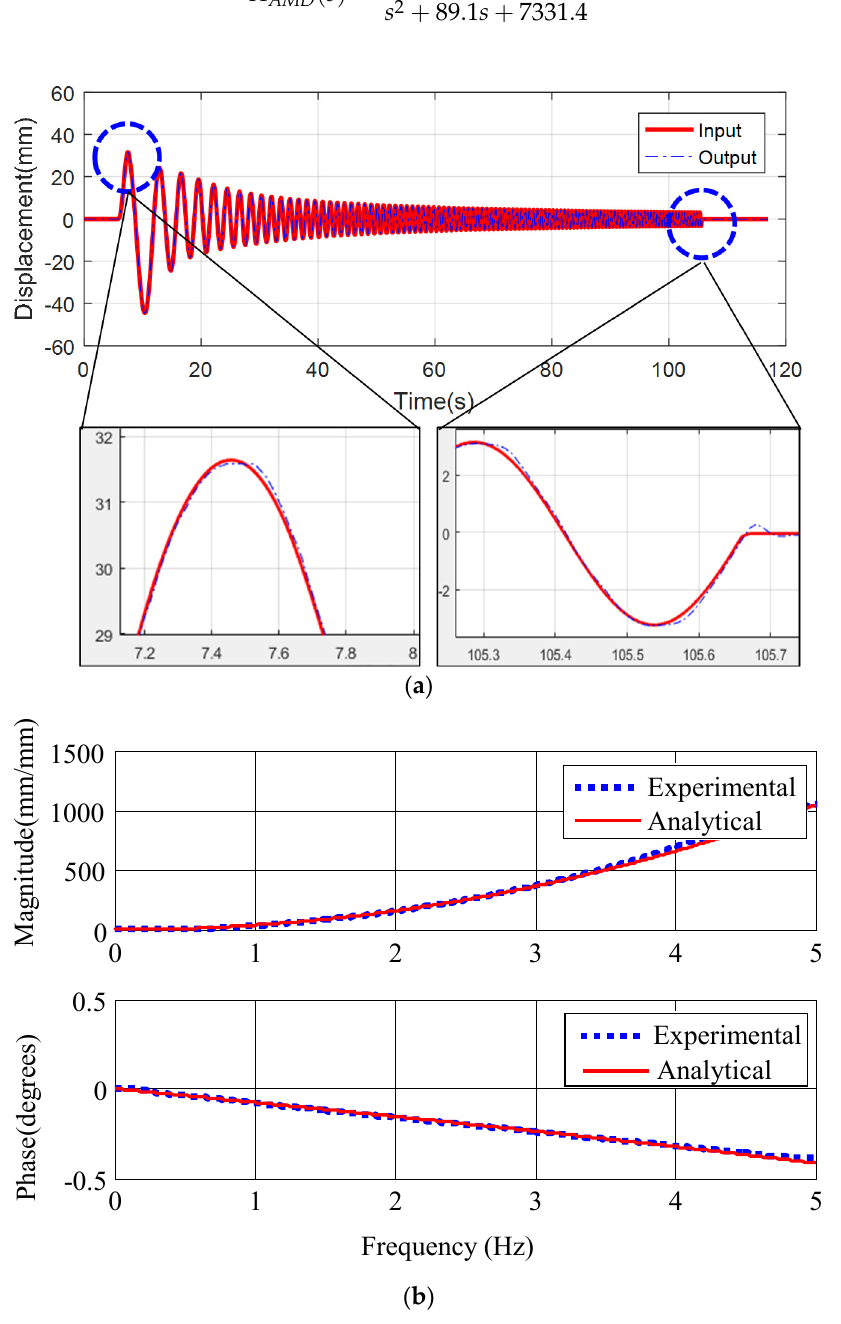
Figure 9. ( a ) AMD input/output and ( b ) transfer function.